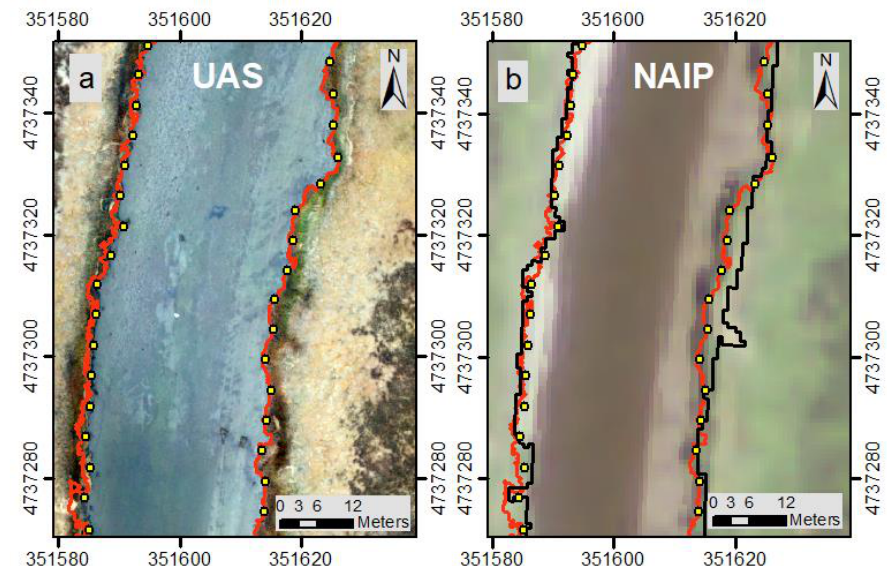
Figure 6. Plum Island, MA (Box 6 in Figure 2) showing ( a ) imagery from UAS; ( b ) imagery from the National Agriculture Imagery Program (NAIP). Yellow dots: Marsh scarp from MEED, red line: Unvegetated / vegetated line from MEIP using UAS data, black line: Unvegetated / vegetated line from MEIP using NAIP imagery.